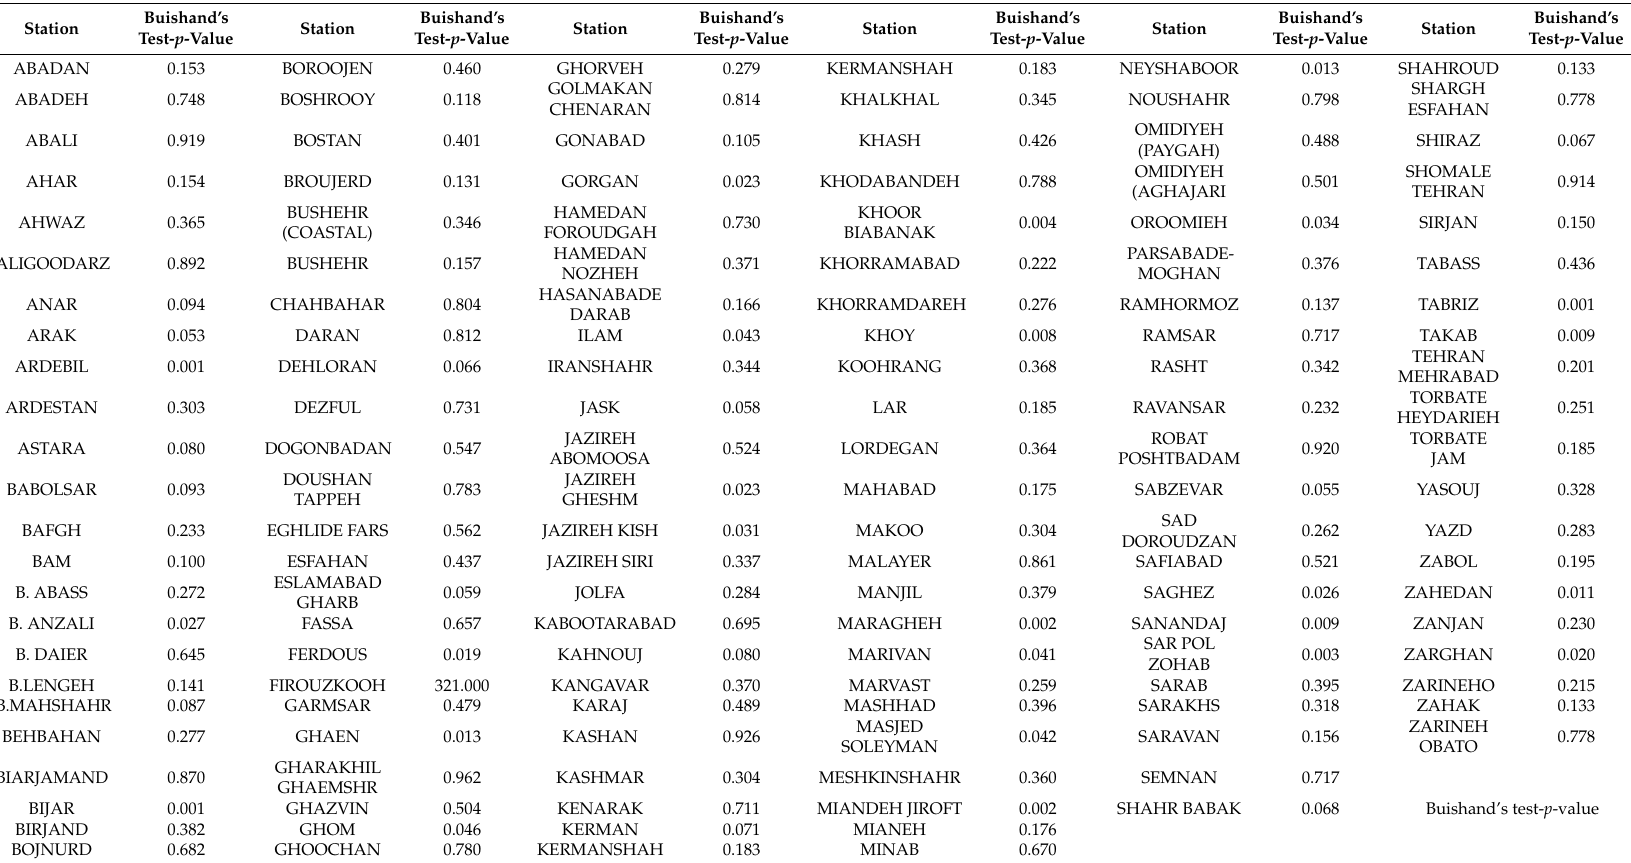
Table 3. Results of Buishand’s test for rainfall in